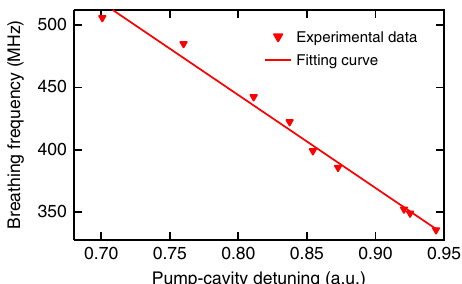
Figure 4 | Numerical simulations of RF spectra at selected detunings. Specific detuning values are D ¼ 3.9 (State 2), D ¼ 4.5 (State 3) and D ¼ 8 (State 4). For comparison, the plot also shows the loaded Lorentzian resonance curve (blue curve; right axis). Note that the RF frequency corresponds to the normalized slow time that is dimensionless. For details on simulations, see Methods. times the cavity photon lifetime. For comparison, on the same plot, we also show the loaded Lorentzian resonance curve of the resonator under consideration on the same axes (right axis; blue curve). The sharpening of the RF beat note can be mathematically explained as follows. Just before the system crosses the boundary from the unstable MI regime to the breather state, the eigenmode associated with the breather state corresponds to the complex eigenvalue with the largest positive real part (that is, the most unstable). As the system enters the breather state, this eigenmode dominates the cavity dynamics while other unstable modes become stable and dampen out over time. As a result, the beat note frequencies of the two distinct states are expected to coincide. The sideband eventually drops to a negligible level with an increased detuning (State 4: D ¼ 8; magenta curve), which signifies the stabilization of the temporal CS, where the pulse reaches a time-stationary state.